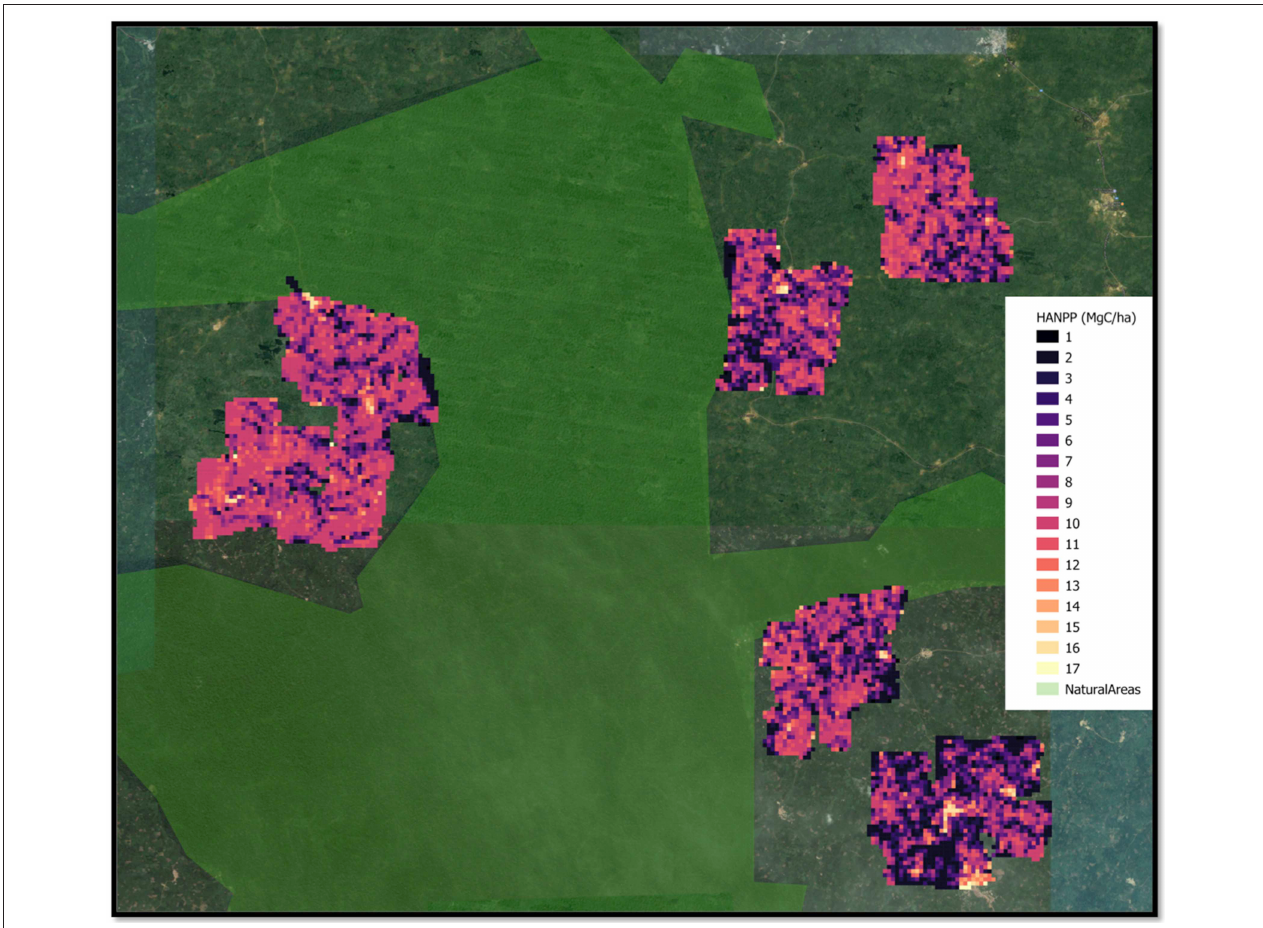
FIGURE 7 | HANPP for all measured regions surrounding Kakum National Park.